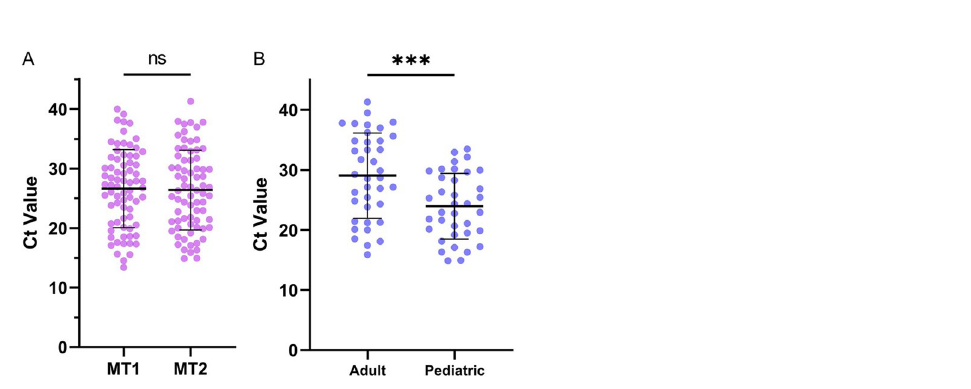
Figure 1. Repeated mid-turbinate sampling does not impact test performance. ( A ) MT1 vs. MT2 mean Ct values did not differ significantly (p = 0.21). ( B ) MT1 Ct values for adult and pediatric participants; pediatric Ct values were significantly lower than adult Ct values (p < 0.01, adjusted for days post-symptom